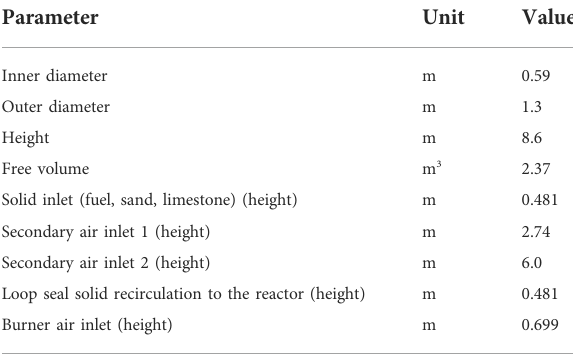
TABLE 1 Design parameters of the